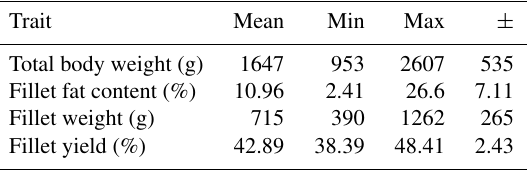
Table 1. Mean, minimum, maximum and standard deviation ( ± ) for the traits body weight (g), fillet fat content ∗ (%), fillet weight (g) and fillet yield (%); n = 33.